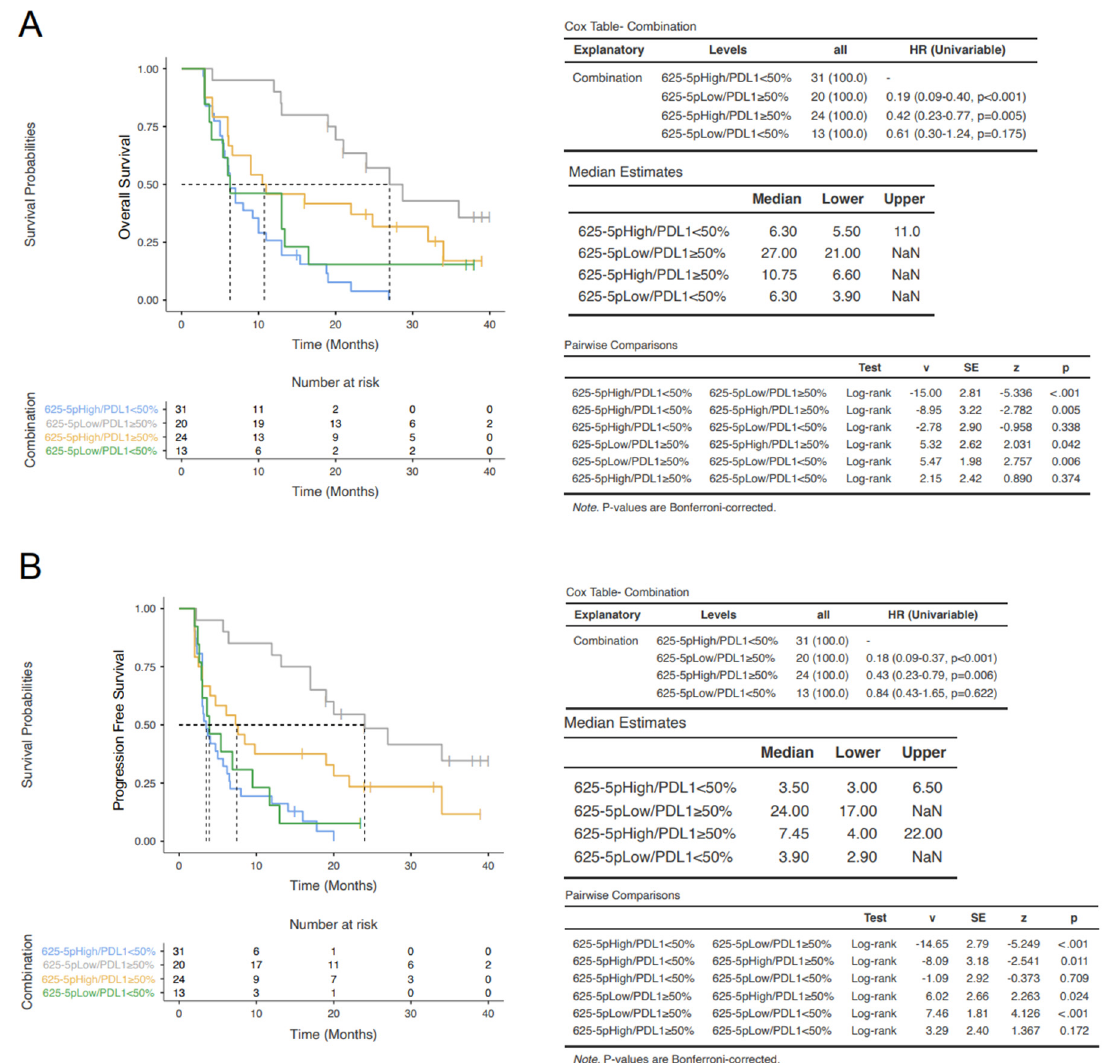
Figure 6. Survival outcomes according to miR − 625 − 5p/PDL − 1 expression. Kaplan–Meier curves reporting the OS ( A ) and PFS ( B ) in the four classes of patients: miR − 625 − 5p High/PDL1 < 50%, miR − 625 − 5p Low/PDL1 ≥ 50%, miR − 625 − 5p High/PDL1 ≥ 50% and miR − 625 − 5p Low/PDL1 < 50%.